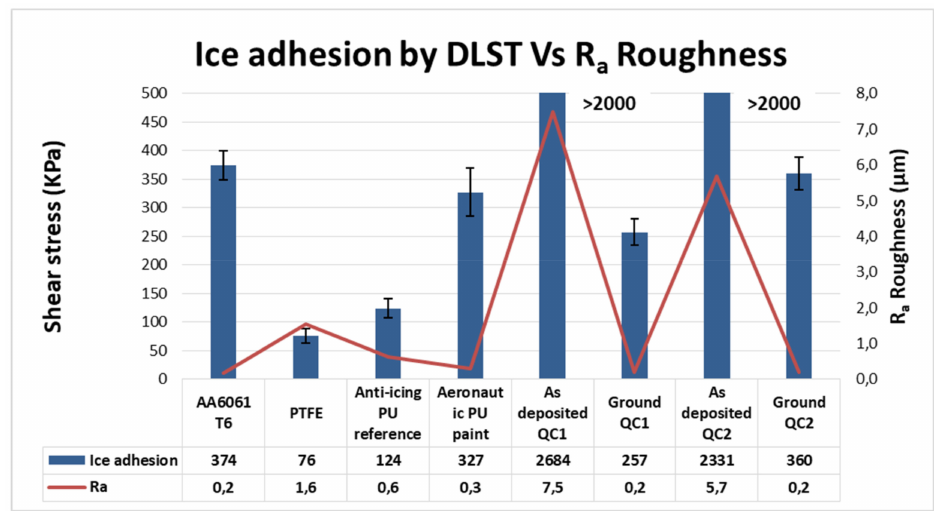
Figure 20. Double lap shear ice adhesion and R a roughness test